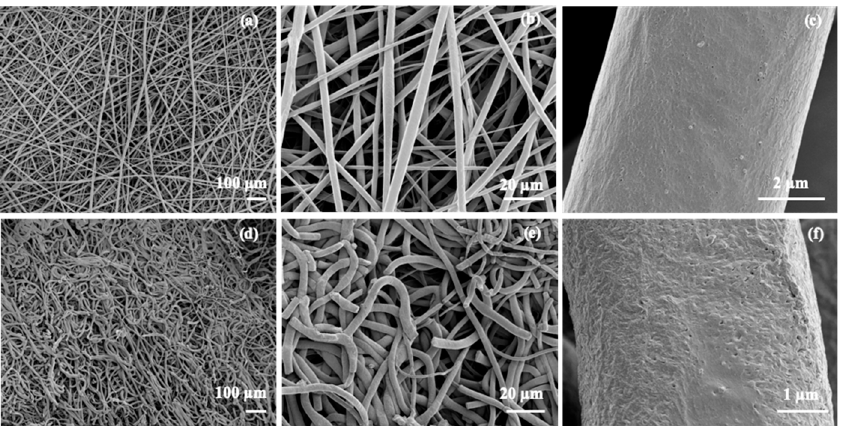
Figure 3. SEM images of electrospun PGl ( a , b and c ) and PGl collected in a solution of MDP – bisTAD ( d , e and f ).